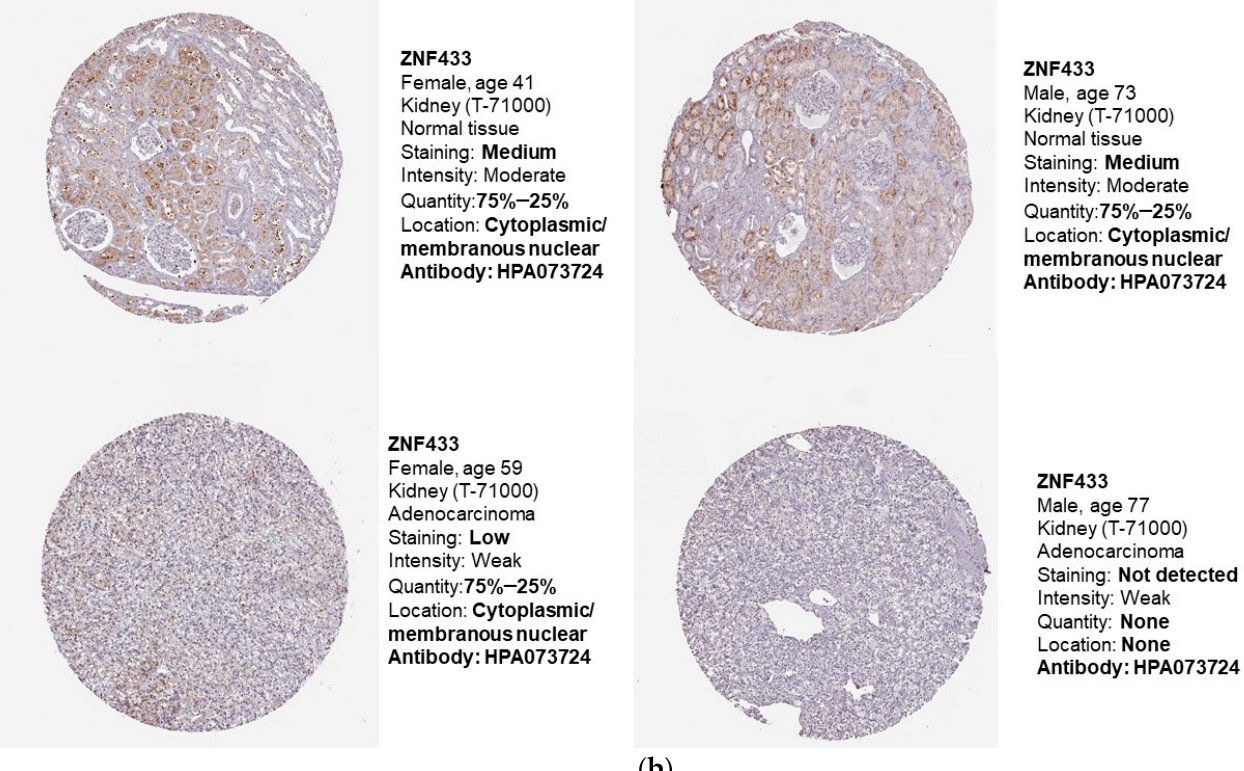
Figure 1. Expression of ZNF433 transcripts and protein in clear-cell renal cell carcinoma. ( a ) Plots were generated using TNMplot analysis (https://www.tnmplot.com, 14 May 2021) of RNAseq data using TCGA datasets. ZNF433 transcripts were significantly downregulated (fold change = 0.65) in tumors ( n = 535) relative to normal tissues ( n = 117). ( b ) Immunohistochemistry from the Human Protein Atlas website (https://www.proteinatlas.org, accessed on 14 May 2021) demonstrating expression of ZNF433 protein in normal and renal cancer tissues. The images are representative of normal kidney and renal adenocarcinoma tissues stained with anti-ZNF433 antibody (HPA073724). Representative images for tumors can be obtained at https://www.proteinatlas.org/ENSG00000197647-ZNF433/pathology/renal + cancer#img (accessed on 14 May 2021), and representative images for normal kidney tissue can be found at https://www.proteinat-